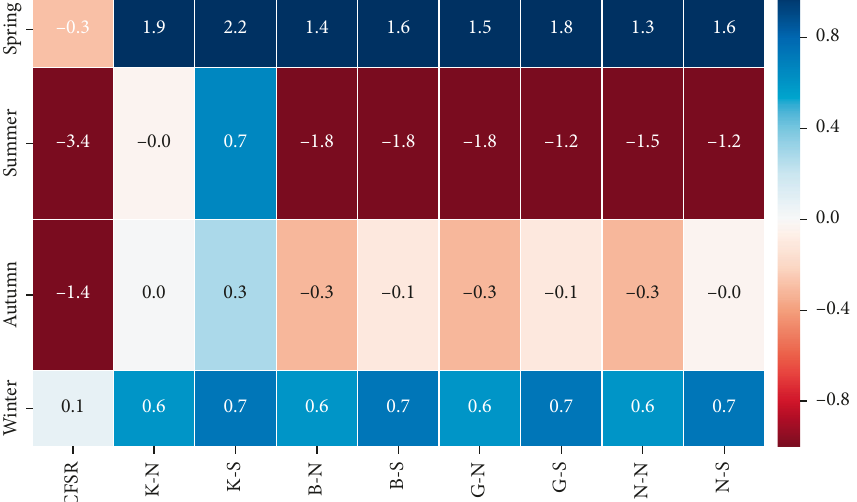
Figure 4: Bias of areal-averaged seasonal precipitation forecasts of CFS reforecasts and the WRF model coupled with different convective and land surface parameterization schemes (mm/day).